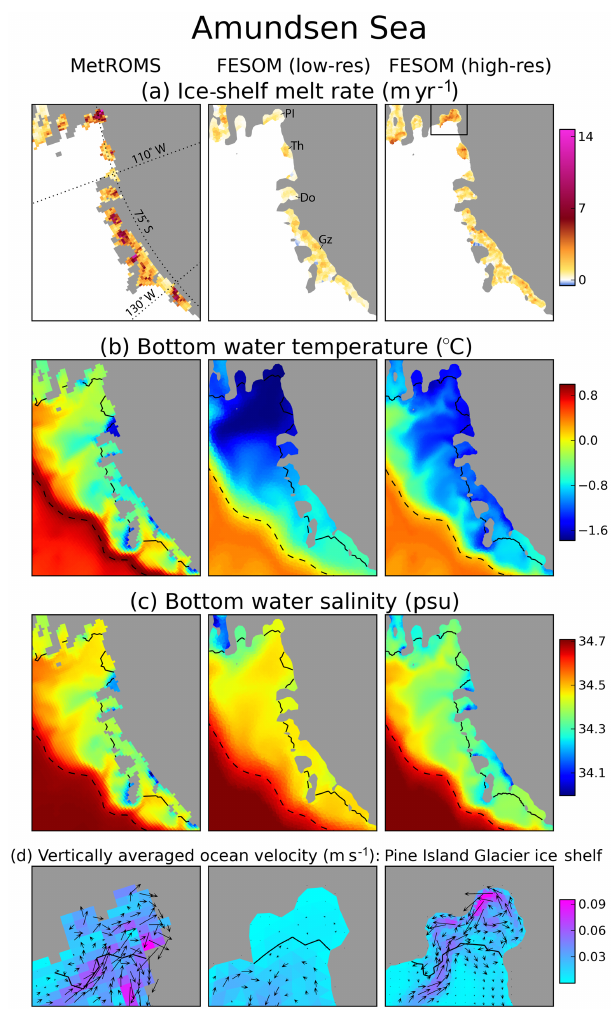
Figure 16. (a) – (c) As Fig. 14a–c for the Amundsen Sea ice-shelf cavities. The dashed black lines in panels (b) and (c) show the 1500m isobath. (d) As Fig. 14d, zoomed into the Pine Island Ice Shelf cavity (region outlined in the rightmost panel of panel a ). PI indicates Pine Island Ice Shelf, Th indicates Thwaites Ice Shelf, Do indicates Dotson Ice Shelf, and Gz indicates Getz Ice